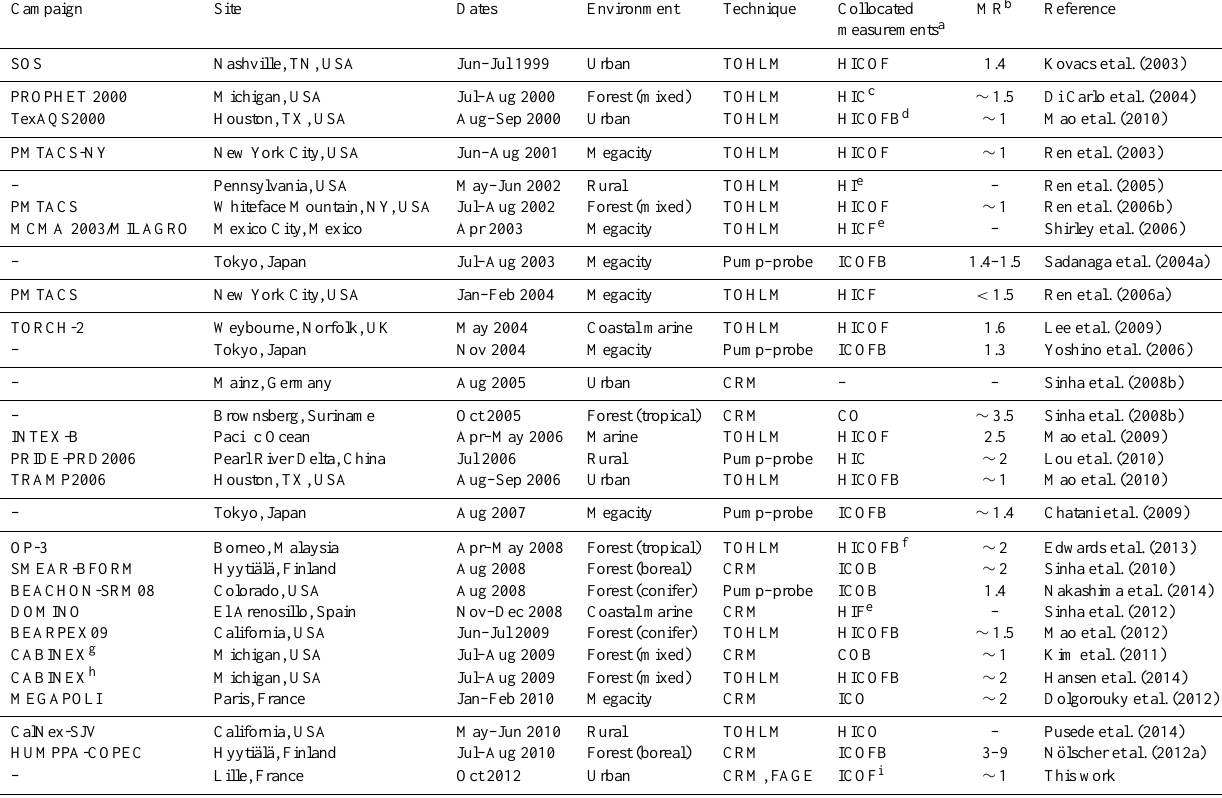
Table 1. Listing of previous OH reactivity field measurement campaigns (updated from Lou et al., 2010 and Hansen et al., 2014). Campaign Site SOS